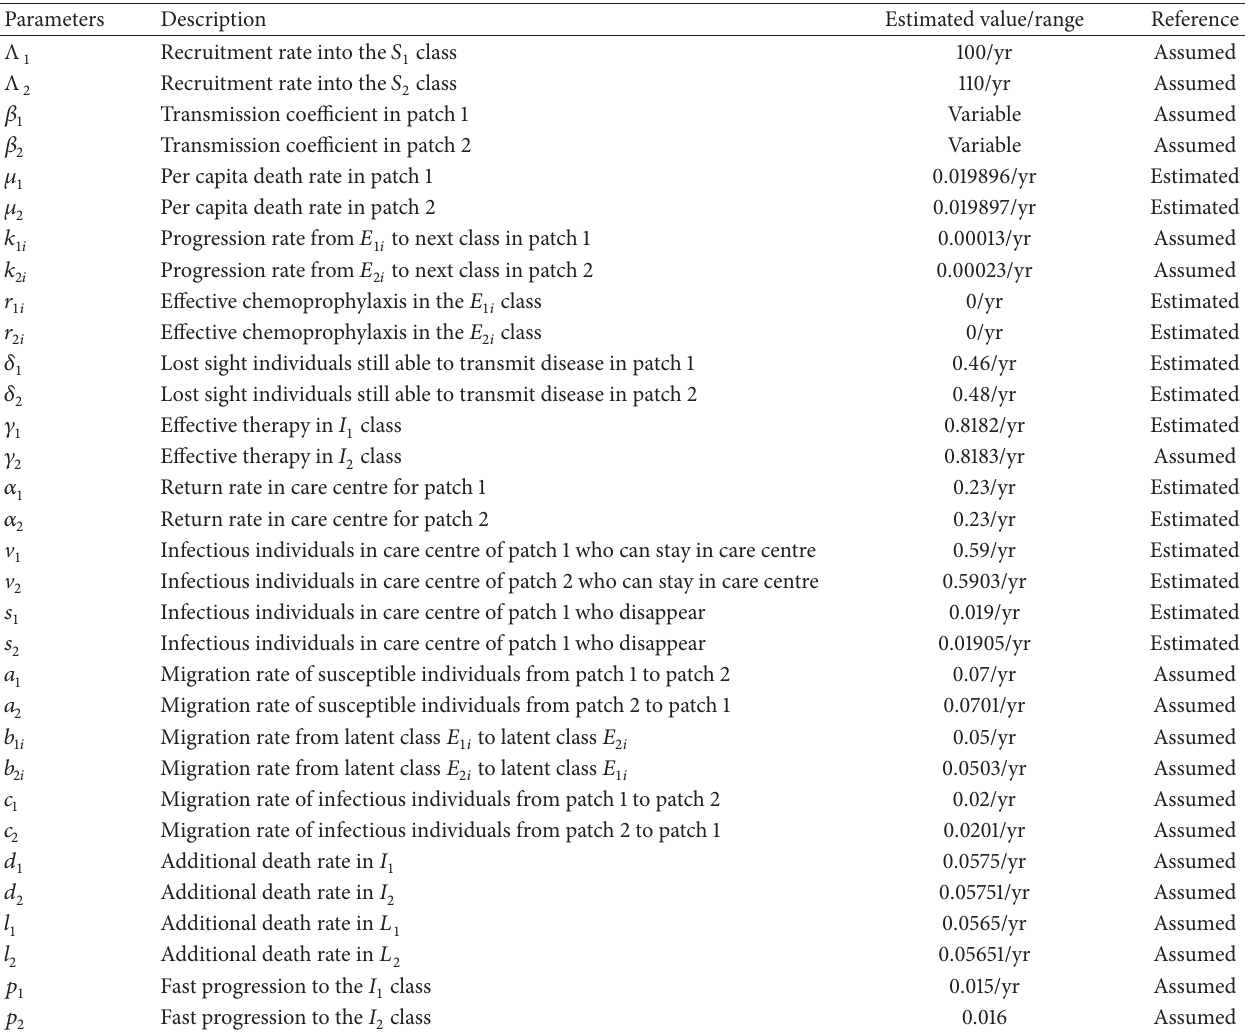
Table 1: Numerical values for the parameters of the